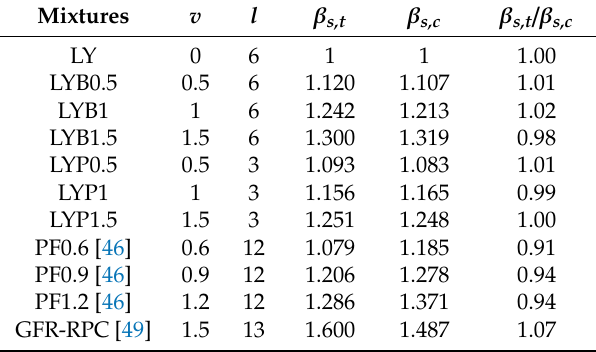
Figure 16. The fitting effect of β s . Table 8. Comparison of test and calculation results of β s.